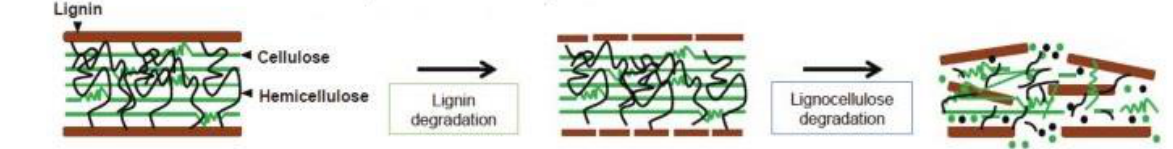
Figure 4. Schematic diagram of lignin degradation by basidiomycetes white-rot fungi [15].